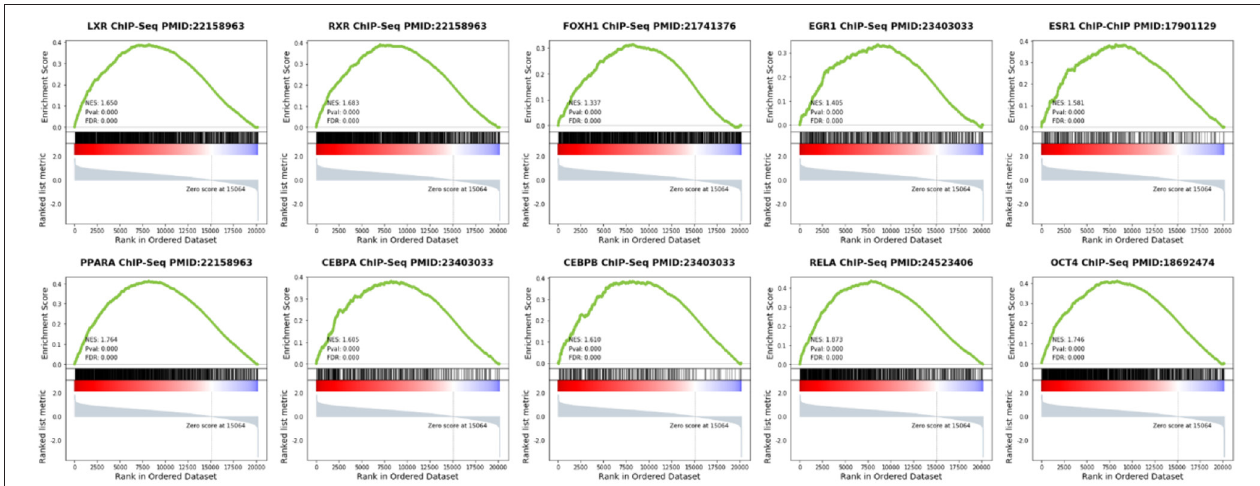
FIGURE 5 | Gene Set Enrichment Analysis (GSEA) of TFs in vascular endothelial cells obtained from FVMs compared with control retinal endothelial